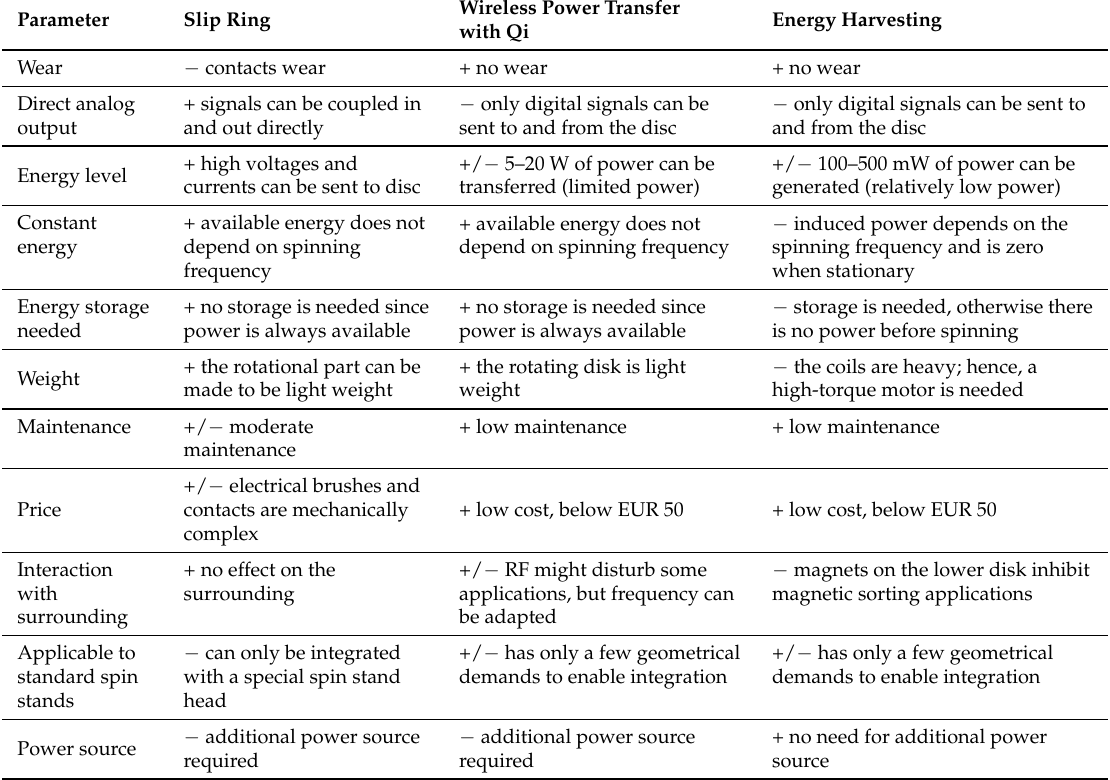
Comparison of different spin stand generations, highlighting the advantages and disadvantages of the slip ring set-up, wireless power transfer with Qi and energy harvesting. Plus (+) and minus ( − ) symbols indicate pros and cons, respectively, for the different categories listed on the left in the table, with neutral aspects indicated by +/ −